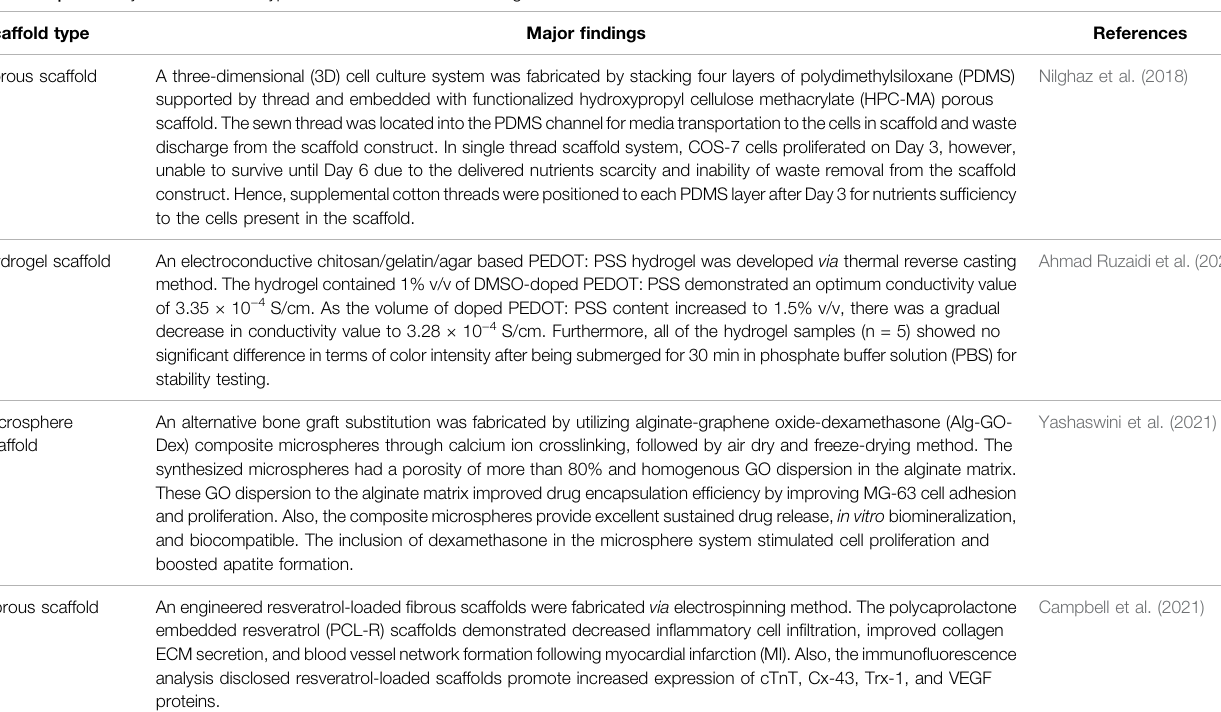
TABLE 1 | Summary on the different types of scaffolds and their fi